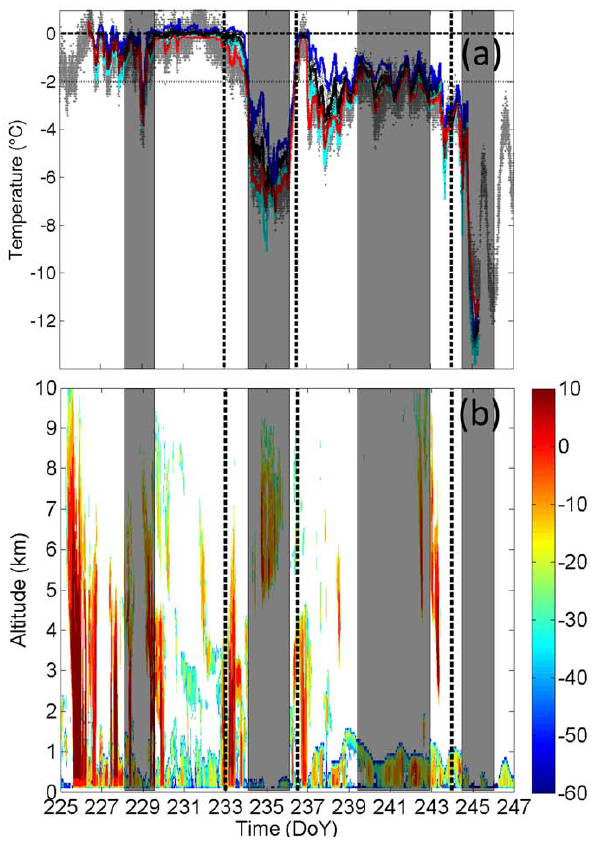
Fig. 3. (a) Time series of several different temperature [ ◦ C] ob- servations: air temperature on board Oden (gray dots); snow sur- face temperatures at 10 different locations (black dots); mean, plus and minus 2 standard deviations (black, blue and red) of the ten snow surface temperature observations; and air temperature 20cm over the surface (cyan). (b) Time–height cross-section of radar re- flectivity [dBZ e ]; from the MMCR cloud radar deployed on board the icebreaker Oden . Being primarily sensitive to hydrometeor size, the deepest red colours represent large ice crystals in, for example, snow or cirrus clouds, while blue and green shading is representa- tive of cloud droplets and rain or drizzle. The plots show roughly the time period of the ice drift; the vertical dashed lines indicate the time regimes discussed in Sect. 3, while the shaded areas indicate the specific periods discussed in this